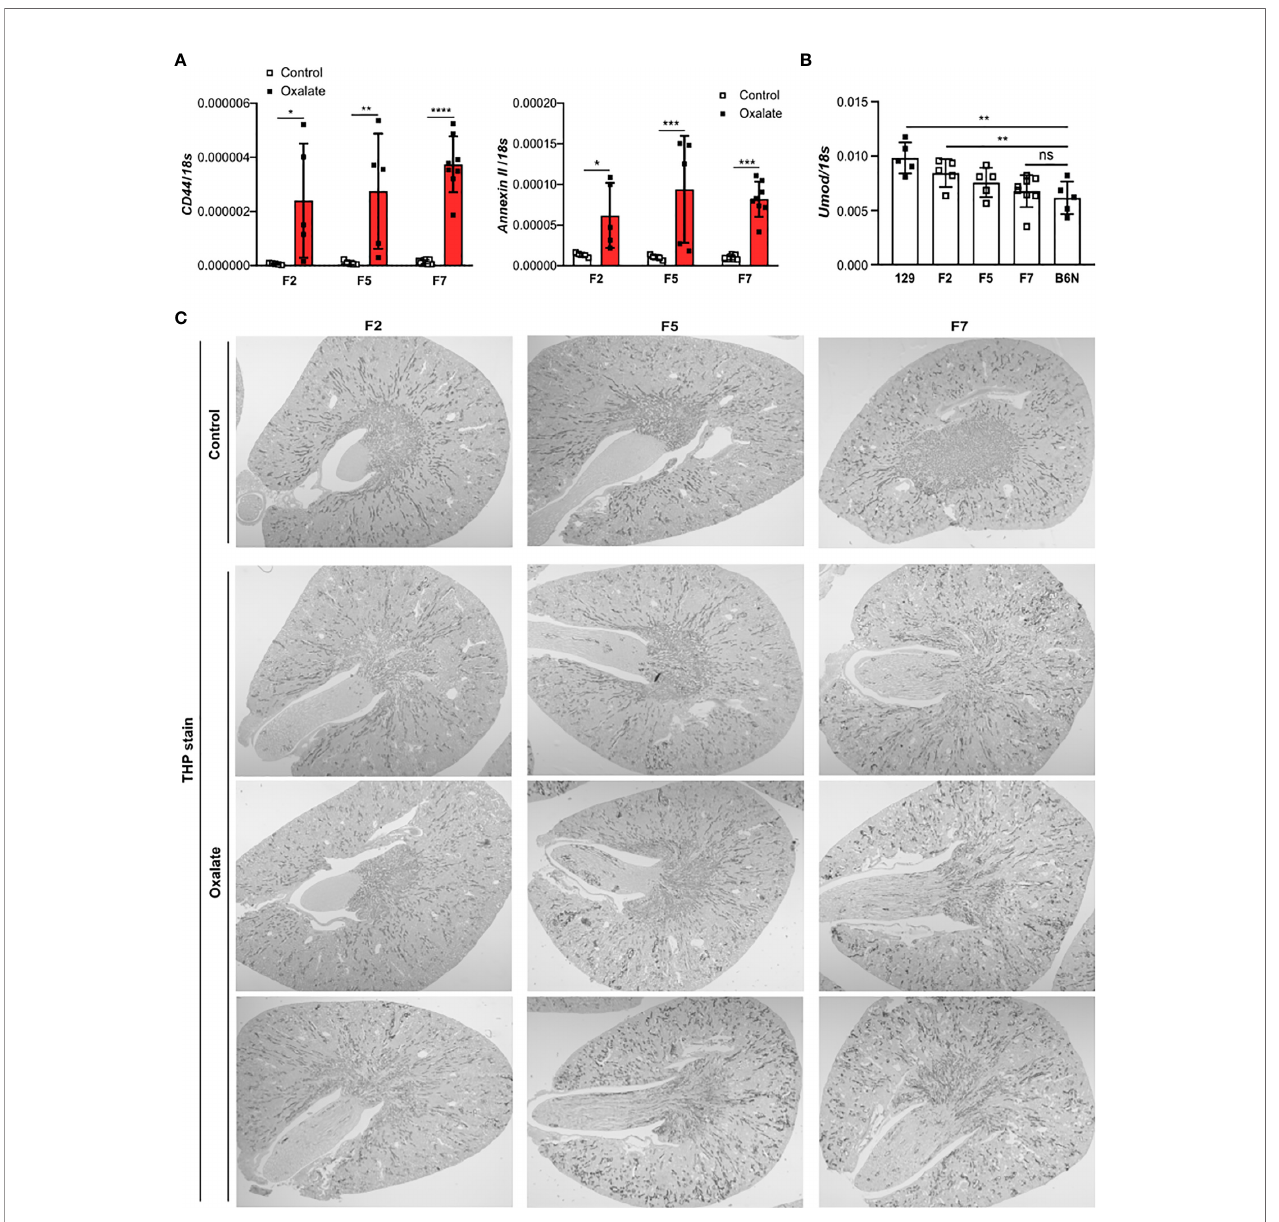
FIGURE 5 | Uromodulin as indicator of the backcross generation in mice. 129/B6N mice were generated by breeding 129 with B6N mice for up to 7 generations (F2, F5 and F7). 129/B6N F2, F5 and F7 mice were either placed on a control diet or oxalate-rich diet for 14 days. (A) Intrarenal mRNA expression of CD44 and Annexin II from mice on both diets determined by RT-PCR. (B) Intrarenal mRNA expression levels of Umod from mice on control diet by RT-PCR. (C) THP staining of kidney sections from all three generations of 129/B6N mice on day 14. Data are mean ± SD from 5 to 8 mice per group. *p < 0.05; **p < 0.01; ***p < 0.001; ****p < 0.0001. ns, not signi fi